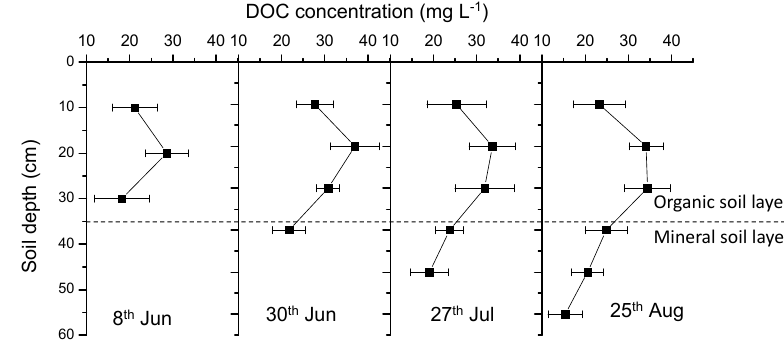
Figure 7. DOC concentrations in soil porewater along the soil profile in 2013.